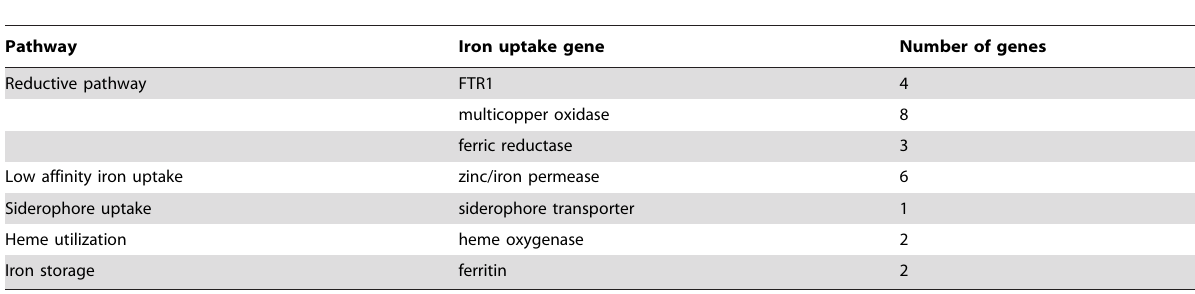
Table 2. Iron uptake genes in the L. corymbifera genome.